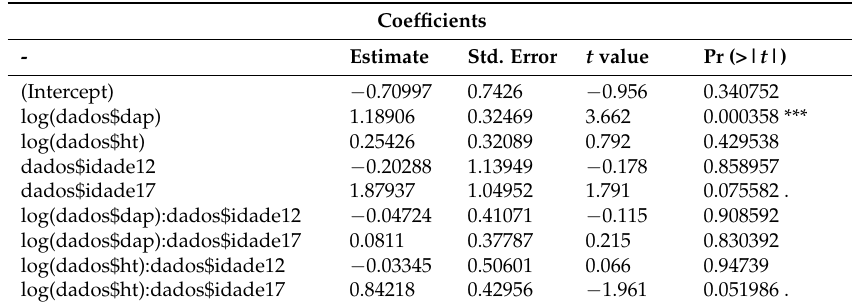
Table A11. R software output table with significance values resulting from ANCOVA for CDM using C 10 as reference for comparison with C 12 and C